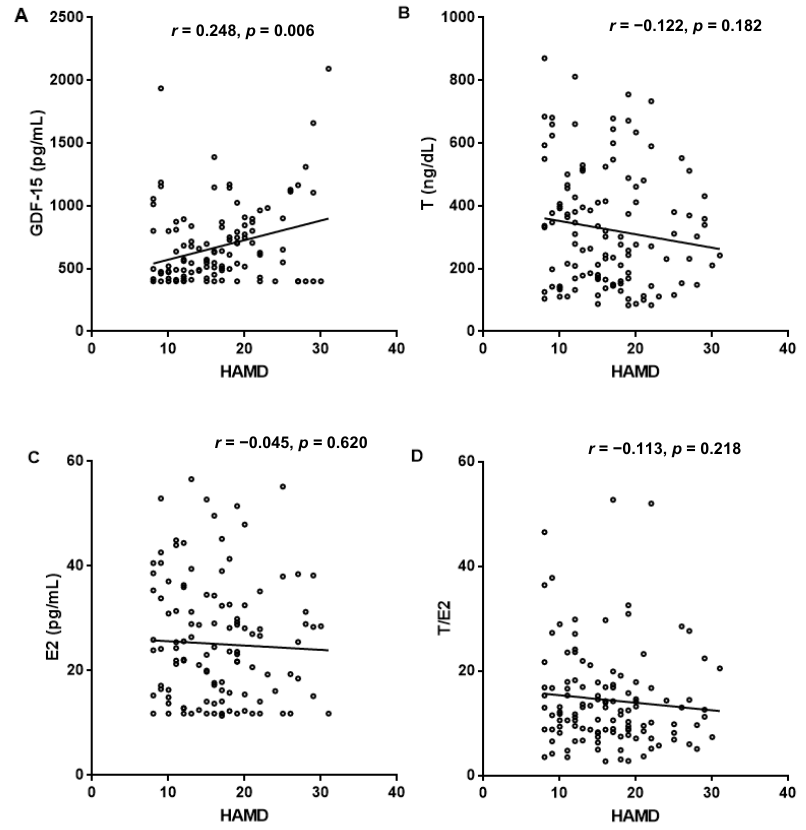
Figure 2. Spearman correlation of sex hormone and circulating GDF-15 levels with HAMD-24 scores in MDD patients.